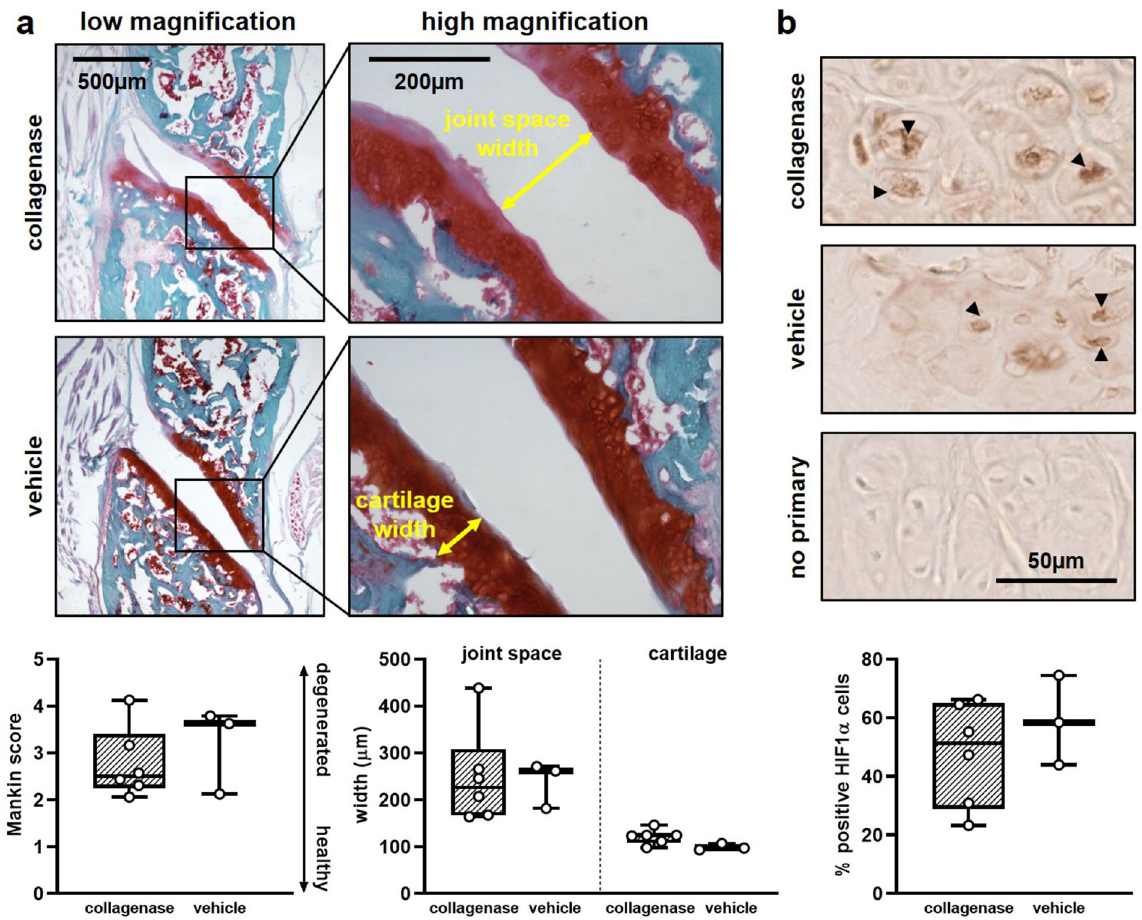
Figure 3. Assessment of damage and health in the facet joint’s cartilage, bone, and articular chondrocytes at 21 days post-injection. ( a ) Low and high magnification images of bone and cartilage staining with Safranin O/Fast Green reveals no significant difference in Mankin score (Wilcoxon test; p = 0.444); a mild decrease in cartilage staining and slight fibrillation is observed in some collagenase-injected joints. Similar to the Mankin score, neither joint space width (two-tailed t-test; p = 0.841) nor cartilage width (two-tailed t-test; p = 0.111) change after intra-articular collagenase (6 joints) compared to intra-articular vehicle (3 joints). ( b ) Images show chondrocytes in the articular cartilage immunolabeled with HIF-1α where black arrowheads indicate positive HIF-1α labeling. For each image, HIF-1α is quantified in regions that are four times larger than those shown in b ; zoomed images are shown here to better visualize chondrocyte labeling. Chondrocytes exhibit a similar pattern of positive labeling regardless of group (collagenase n = 6; vehicle n = 3) that is not different (two-tailed t-test; p = 0.423). An image of the no primary, negative control for the HIF-1α label is also shown. Box-and- whisker plots show horizontal lines representing the first (lower) quartile, median, and third (upper) quartile of the data. Whiskers represent the minimum and maximum of the data set. Data points for individual joints are superimposed on boxplots and show the mean value from 6–8 images/rat for the Mankin score, 3–4 images/rat for the joint space and cartilage width measurements, and 5 images/rat for the HIF-1α